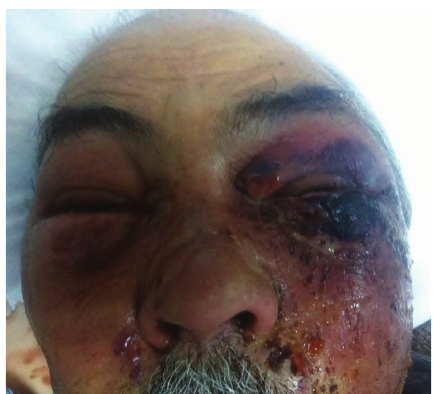
Figure 2: The necrosis spread within